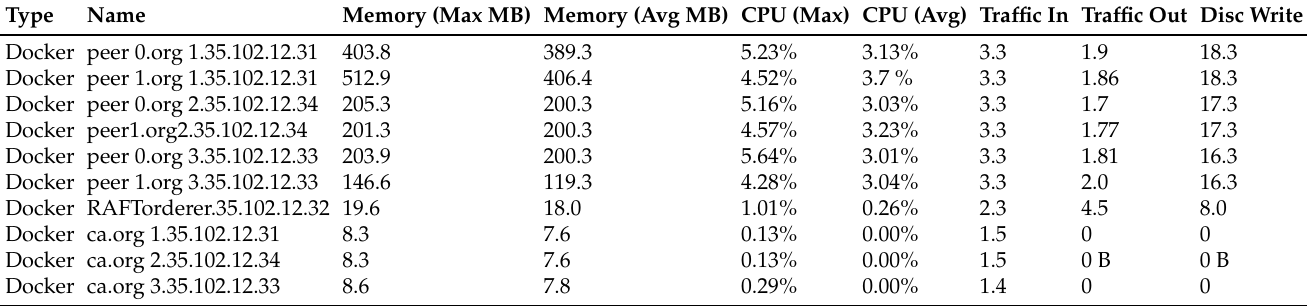
Table 4. Resource consumption after first round (RAFT).